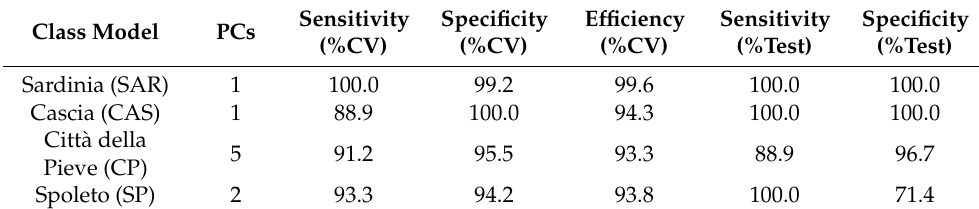
Table 2. Results of SIMCA models on the individual